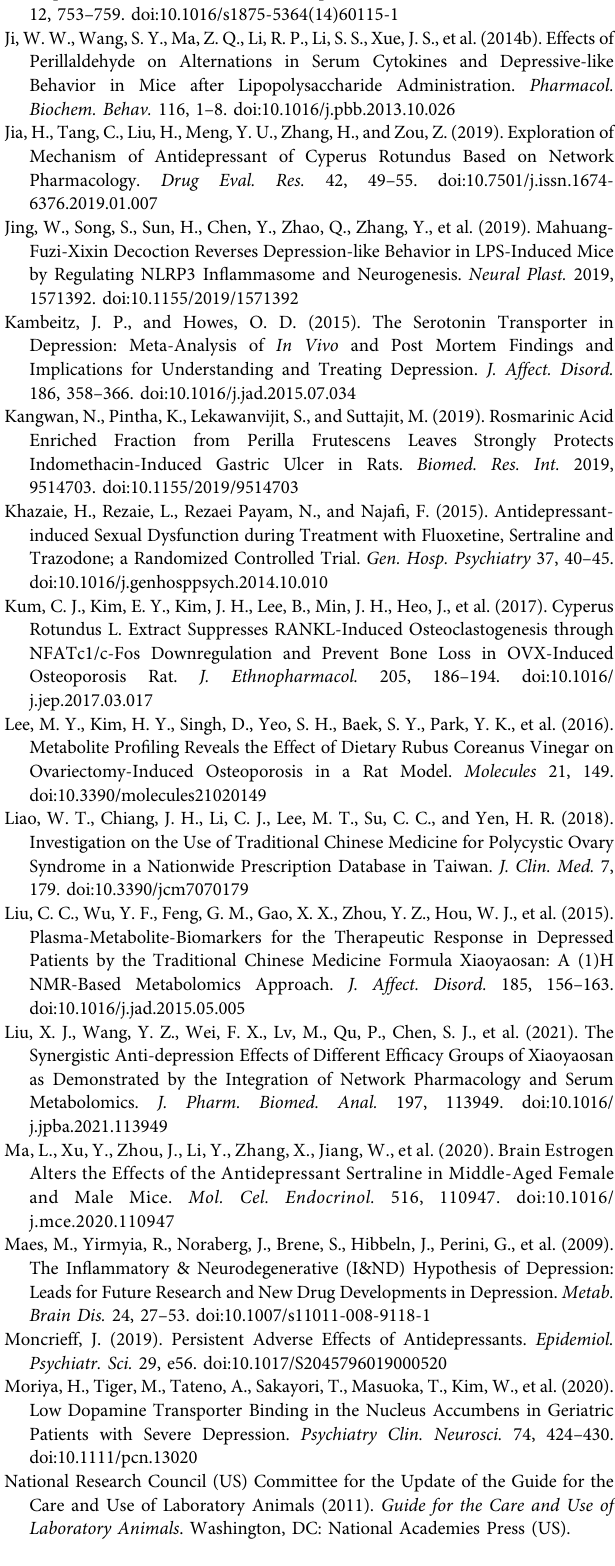
National Research Council (US) Committee for the Update of the Guide for the Care and Use of Laboratory Animals (2011). Guide for the Care and Use of Laboratory Animals . Washington, DC: National Academies Press